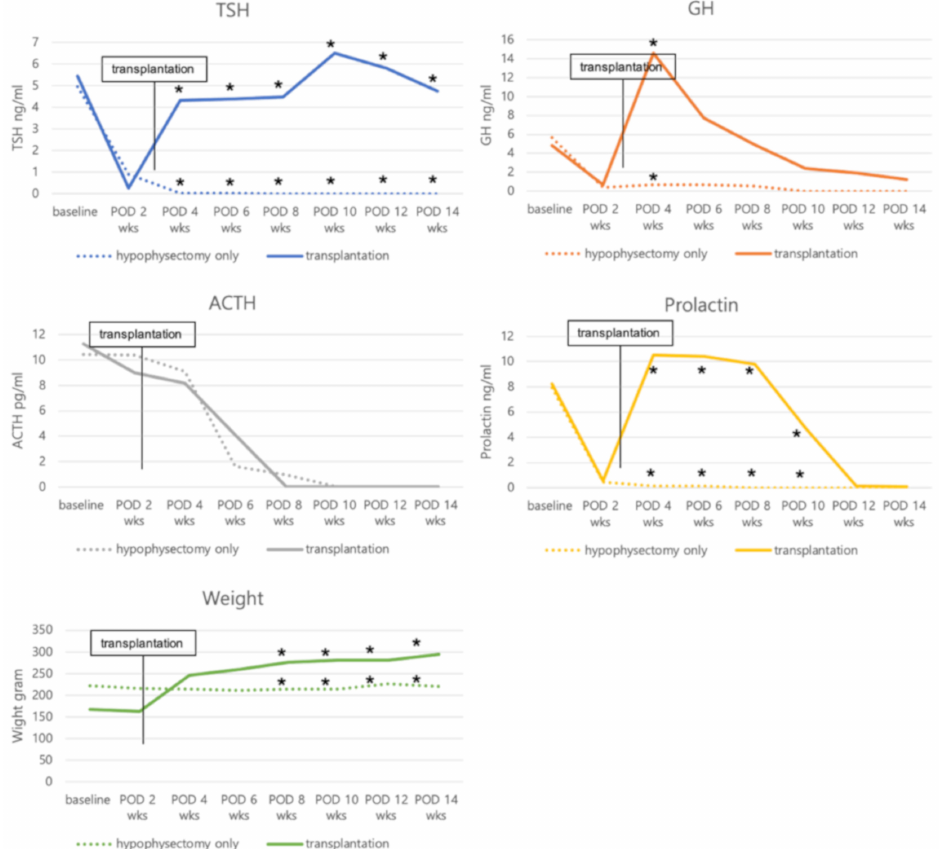
Figure 6. Mean TSH levels after transplantation were significantly higher compared to the hypophysectomy-only group and maintained until 11 weeks after transplantation. Serum GH and prolatin levels normalized at 1 week after transplantation and mean GH levels were significantly higher in the transplantation group than in the hypophysectomy-only group. There was no significant difference in the mean ACTH levels between the two groups. Mean body weight was significantly different between the two groups from 8 weeks posthypophysectomy. POD, postoperative day; * p <